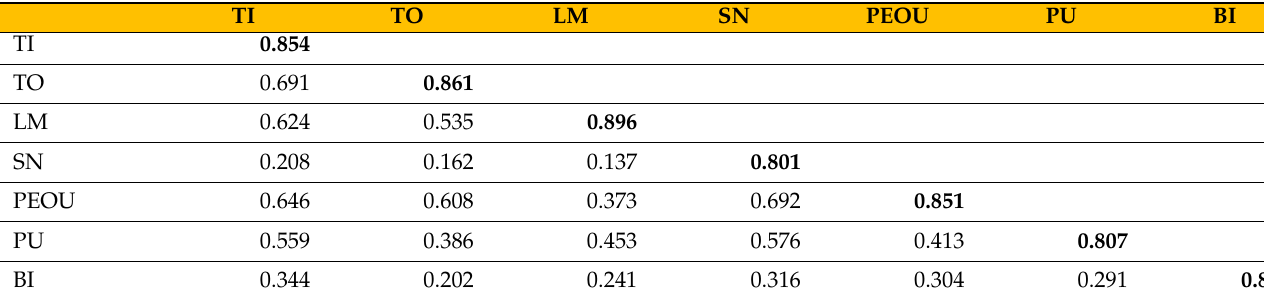
Table 4. Fornell–Larcker